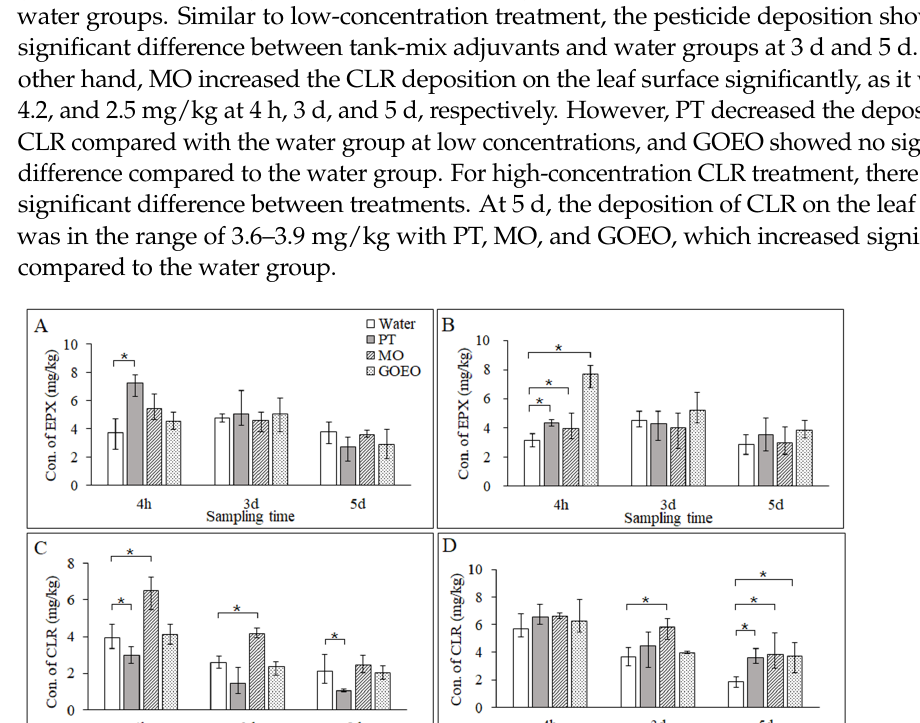
Figure 4. The concentrations of EPX and CLR in rice shoots: ( A ) EPX at 125 mg/L, ( B ) EPX at 187 mg/L, ( C ) CLR at 66.7 mg/L, and ( D ) CLR at 100 mg/L. * p < 0.05.